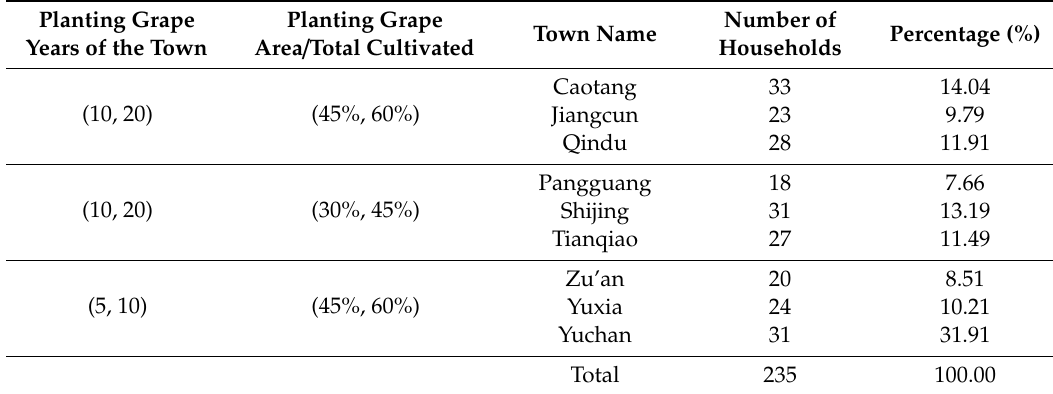
Table 1. Distribution of the sampled households growing grape.